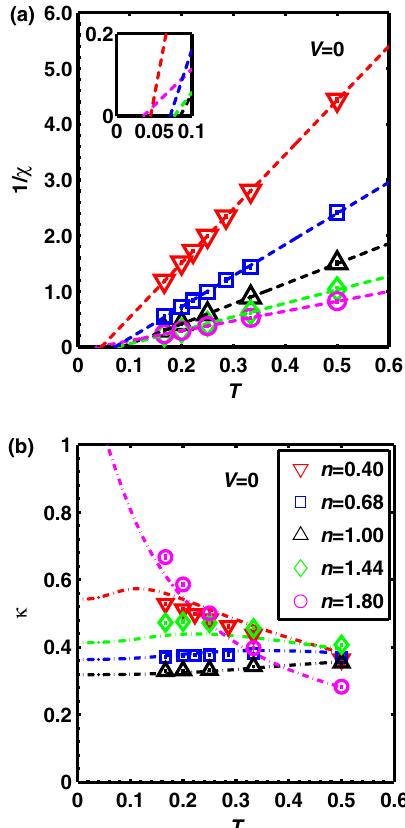
FIG. 1. (a) χ − 1 ð T Þ exhibits the CW law at different values of n . The inset shows interceptions corresponding to the mean-field value of Curie temperature T 0 . (b) The compressibility κ ð T Þ at different values of n . The dashed lines represent κ ð T Þ of 1D spinless fermions at the same densities for comparison. Values of n in (a) and (b) are represented by the same legend. V ¼ 0 and J ¼ 2 for both figures. The error bars of the QMC data are smaller than the